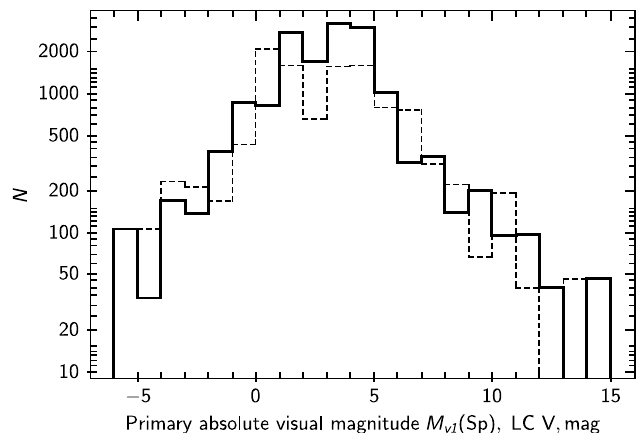
Fig. 3. Distribution of absolute visual magnitudes of luminosity class V primaries. The dotted and solid lines show the distributions of absolute magnitudes determined using the calibrations of Straiˇzys (1982) and those of Mamajek (2014) and Pecaut & Mamajek (2013), respectively. The visible depression between magnitudes 2 and 3 is due to non-uniformity of spectral